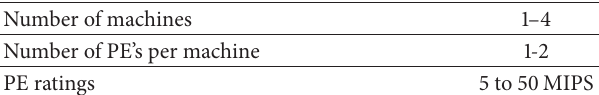
Figure 3: Gridsim architecture. Table 1: Grid resource characteristics.